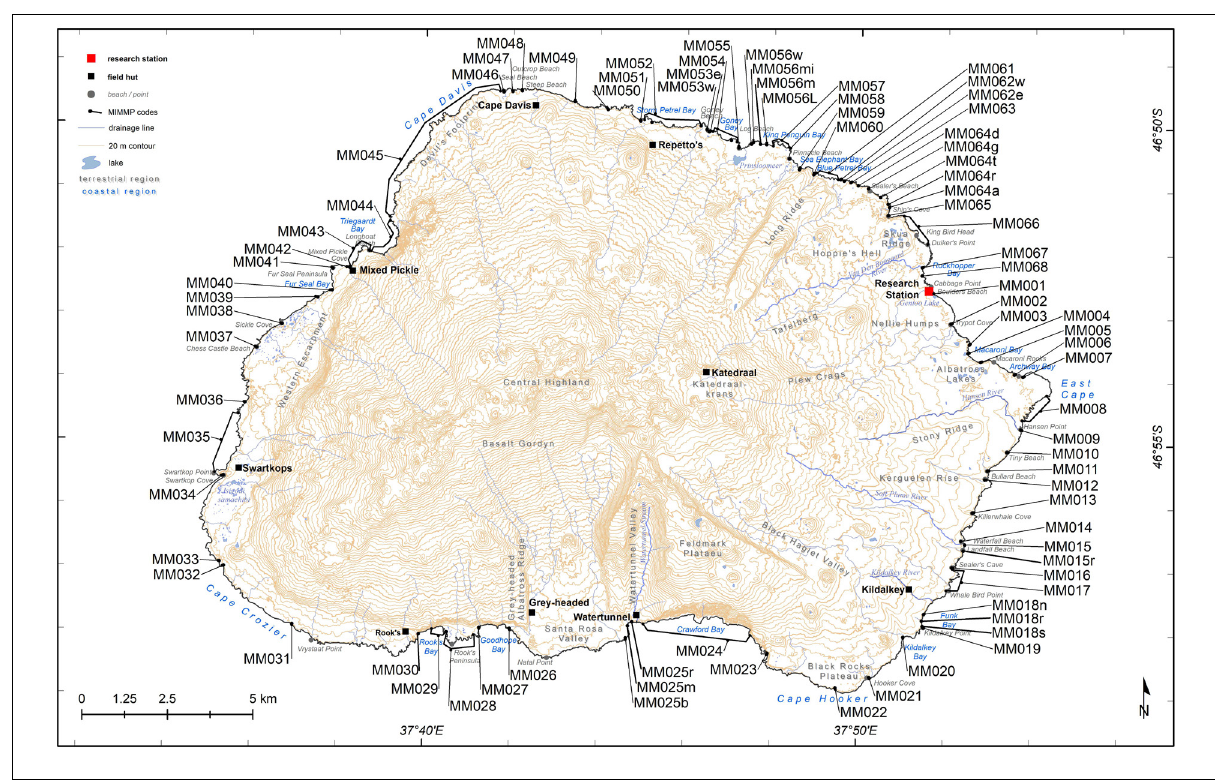
Figure 4: A preview of the map indicating names and codes of beaches and zones used in marine mammal monitoring research programmes at Marion Island. Detailed descriptions and coordinates can be found in Supplementary table 3 and the map is available to download from the open access dataset (see Table 1). Projection: Transverse Mercator CM37E.